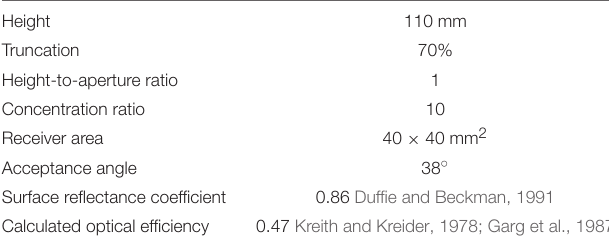
TABLE 2 | The Specifications of the CPC used for the